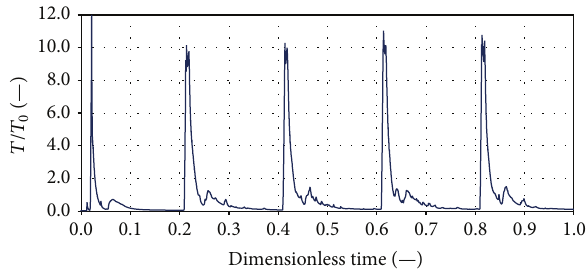
Figure 9: Dimensionless resistant torque curve resulting from cal- culation.